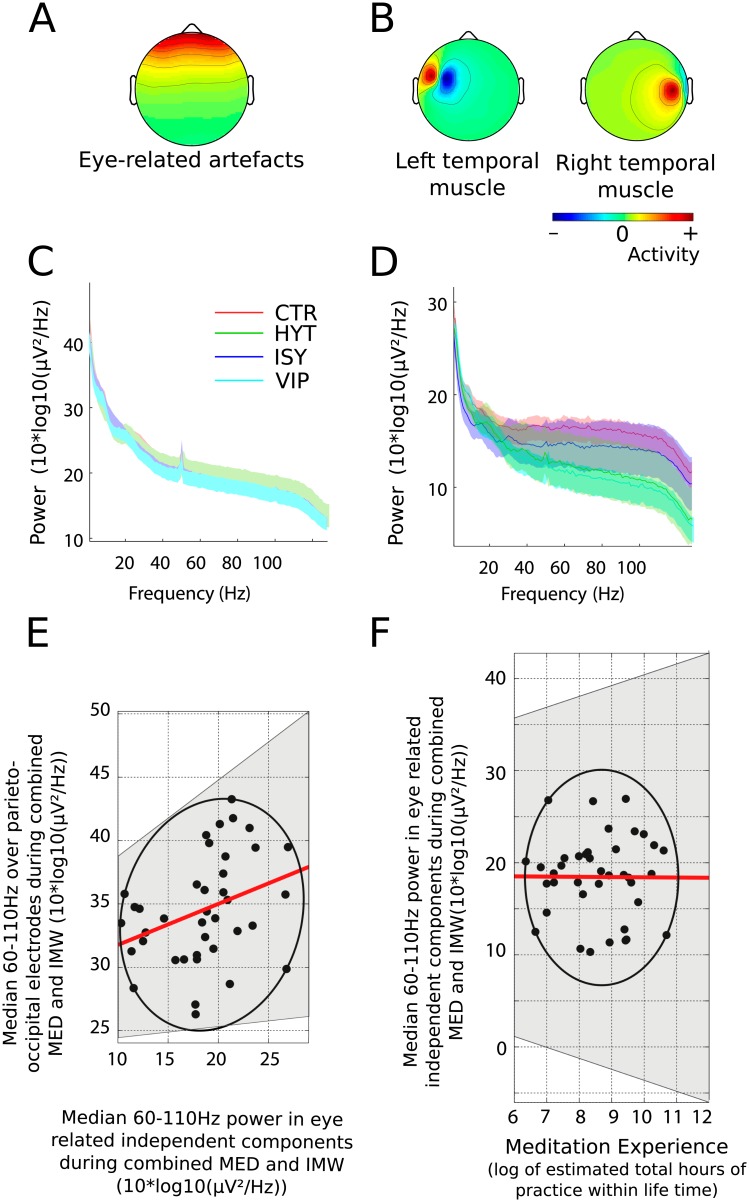
A. Average scalp topography of independent components’ activity corresponding to eye related artifacts. B. Average scalp topographies of independent components’ activity for left and right temporal muscle activity. C. No difference was observed between groups for eye movement independent components’ spectral activity in the meditation condition. D. Pooled left and right muscle ICA components spectral activity for the meditation condition indicate no significant difference between the 4 groups of subjects. E. There is a positive correlation between the 60–110 Hz activity in the components of eye related artifacts and the 60–110 Hz activity recorded over the parieto-occipital electrodes in combined MED and IMW conditions (skipped Pearson’ s r = 0.33, CI = [0.10 0.56]). F. The 60–110 Hz activity in the artifactual components related to eye artifacts do not correlate with meditation experience (skipped Pearson’s r = −0.006, CI = [-0.29 0.30]). In both panels C and D the shaded area around the curves represents the standard error to the mean. In panels E and F the shaded area represents the 95% confidence interval (CI).